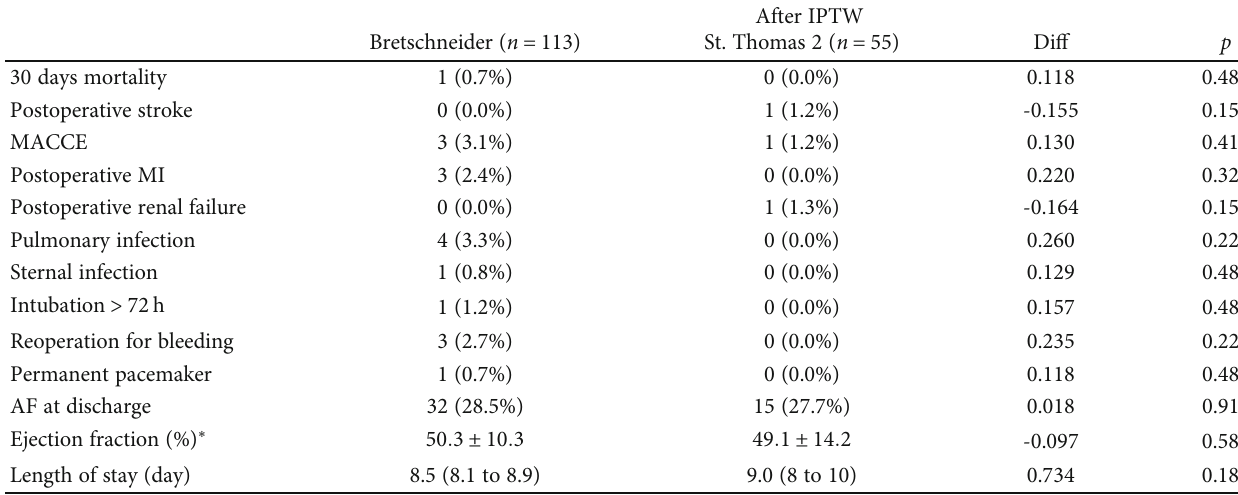
Table 3: Postoperative outcomes: clinical outcomes.